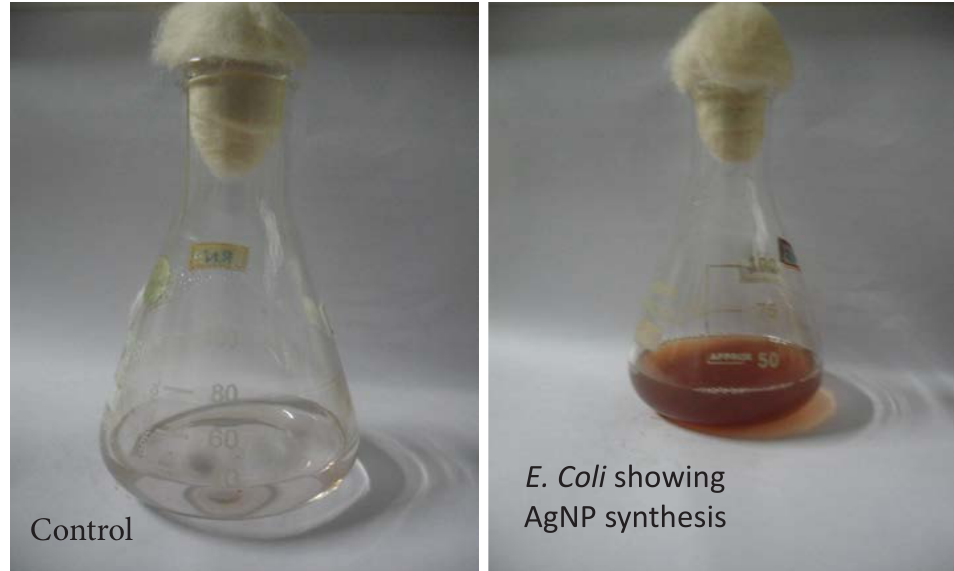
Fig. 1. Synthesis of nanoparticle by Escherichia coli